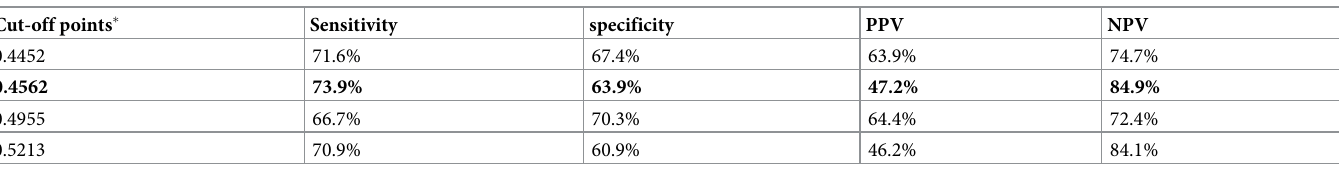
Table 5. Performance of the nomogram at different cut-off points.